Question: What direction does the quantity move in — increasing or decreasing?
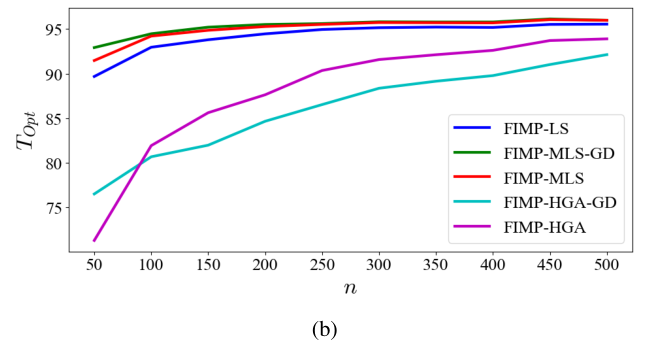
Answer: increasing